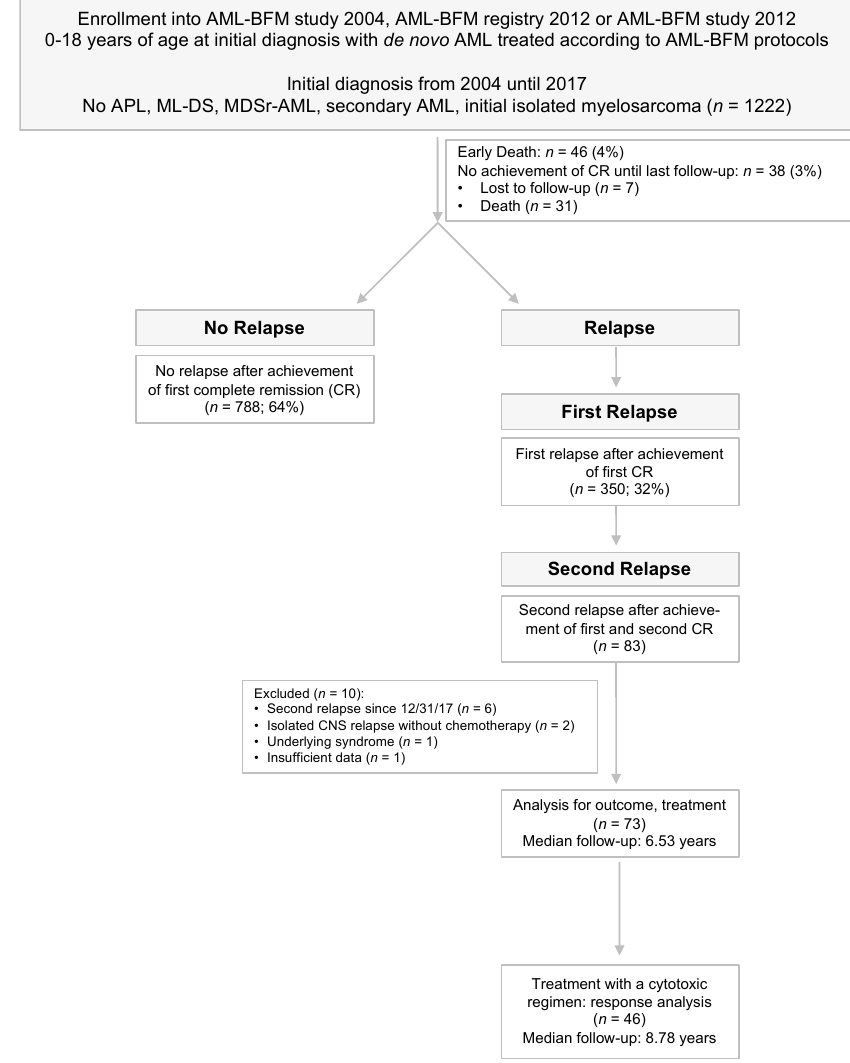
Figure 1. CONSORT diagram. CONSORT flow diagram showing patients of the acute myeloid leukemia- Berlin-Frankfurt-Munster (AML-BFM) studies and registries from 2004 und 2017 that have been included or excluded from the retrospective analysis. Abbreviations: ML-DS, patients with Down syndrome myeloid leukemia; APL, acute promyelocytic leukemia; MDSr-AML, AML with myelodysplasia related changes; CR, complete remission.